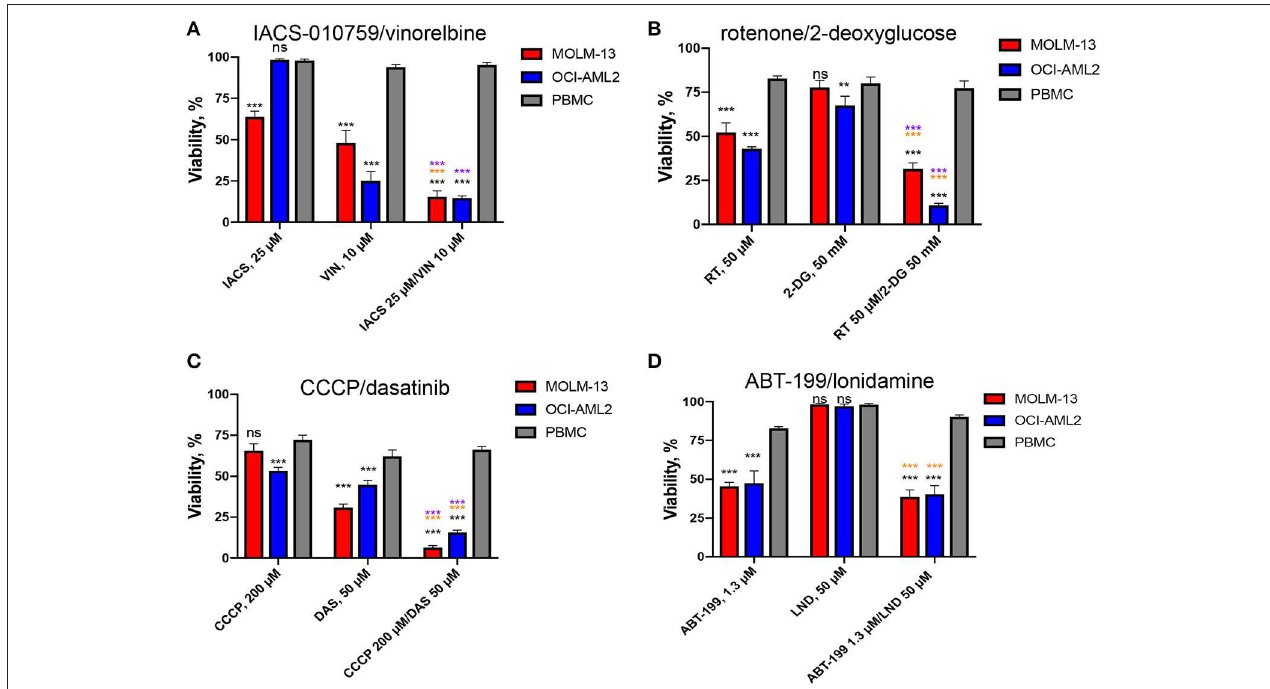
FIGURE 4 | Effect of top selective drug combinations and corresponding single drugs on AML cell lines and healthy PBMCs. Survival of MOLM-13, OCI-AML2, or healthy PBMCs following single and combinatorial treatments with dosages corresponding to the maximal average difference in survival of AML vs. PBMCs. (A) IACS-010759/vinorelbine, (B) rotenone/2-deoxy-D-glucose, (C) CCCP/dasatinib, (D) ABT-199/lonidamine. Shown are the mean from at least three independent biological replicates (mean ± SEM). Significance of changes in survival was assessed via Student’s t -test. *** p < 0.001; ** p < 0.01; ns: p > 0.05. Black stars or ns indicate comparison of AML cells vs. healthy PBMCs under the same treatment condition; purple stars indicate significantly lower survival under combinatorial treatment compared to single mitocan for each cell line; orange stars indicate significantly lower survival under combinatorial treatment compared to single complementary drug for each cell